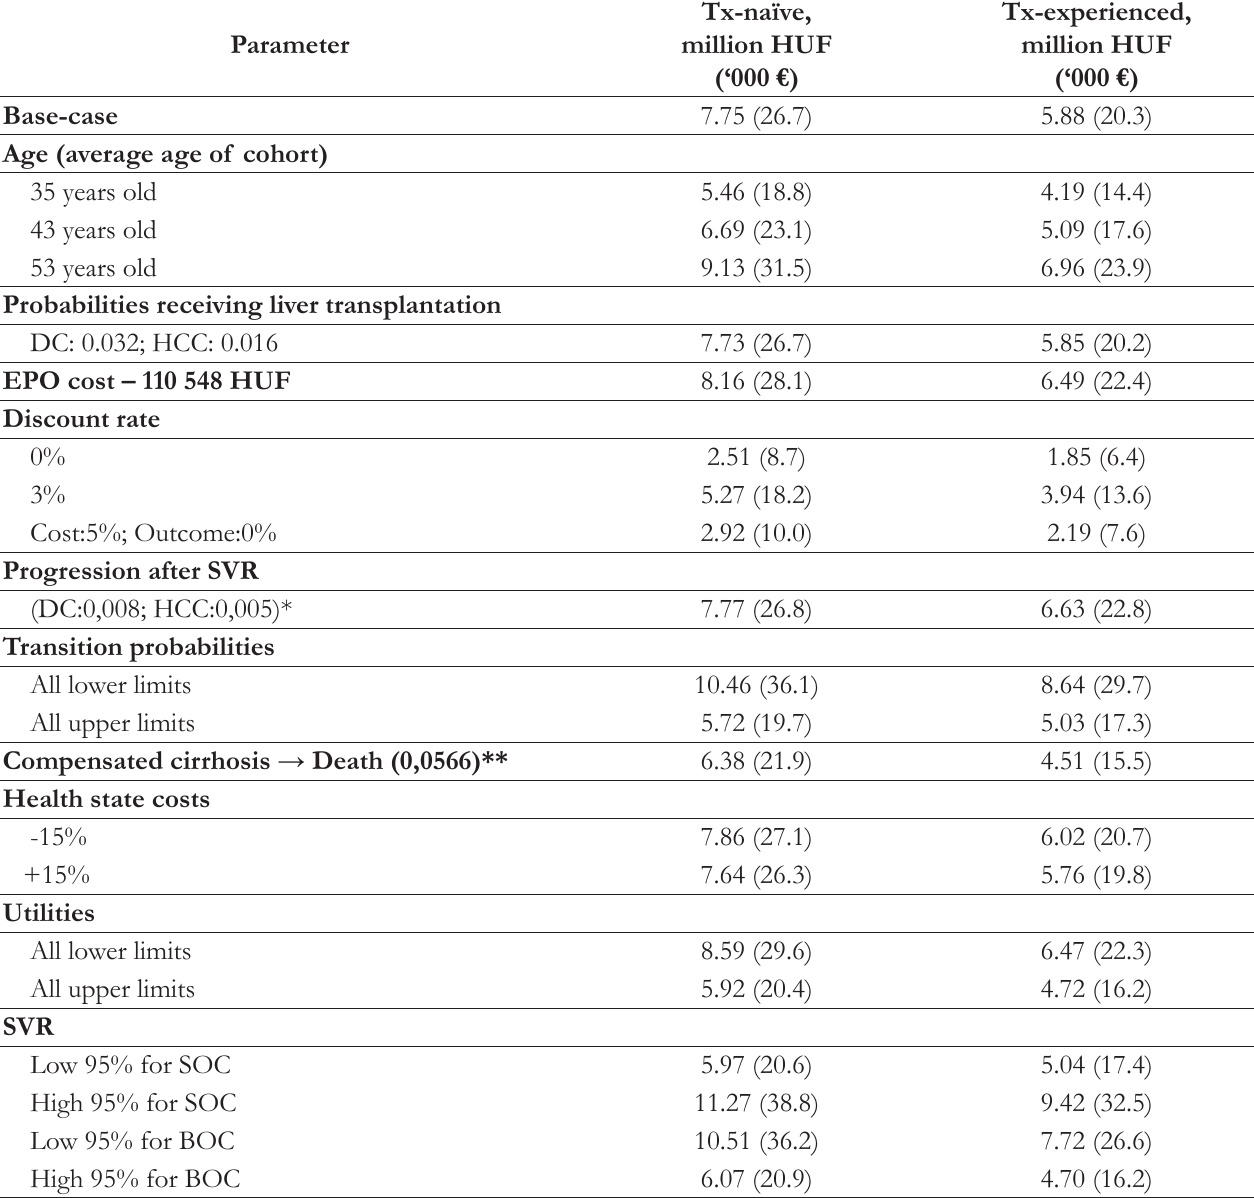
Table 9. The Deterministic Sensitivity Analysis Results (ICER; million HUF)